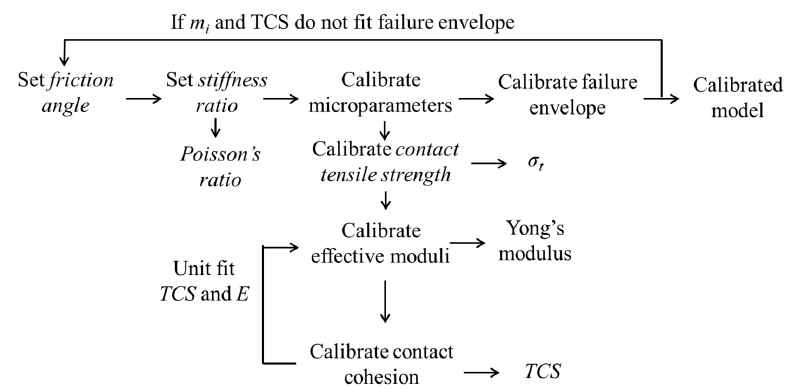
Figure 3. The “trial and error” method used to check the process of the particle flow code (PFC) model (Modified from Castro-Filgueira et al. (2017) [39] .